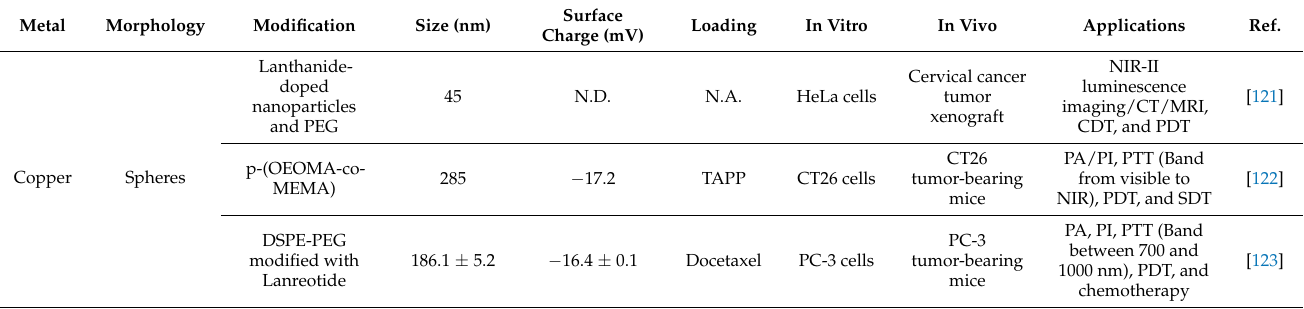
Table 3. Copper-based metallic-polymer nanoconjugates/nanohybrids, their physicochemical prop- erties, and therapeutic applications (N.D.—non disclosed, N.A.—not